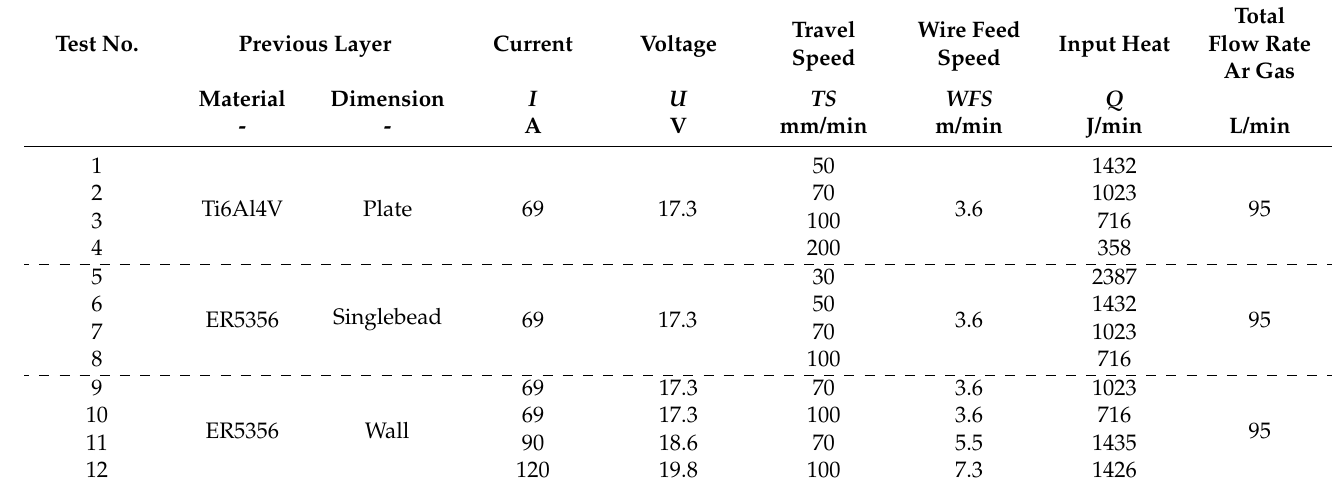
Table 3. Processing parameters for Ti